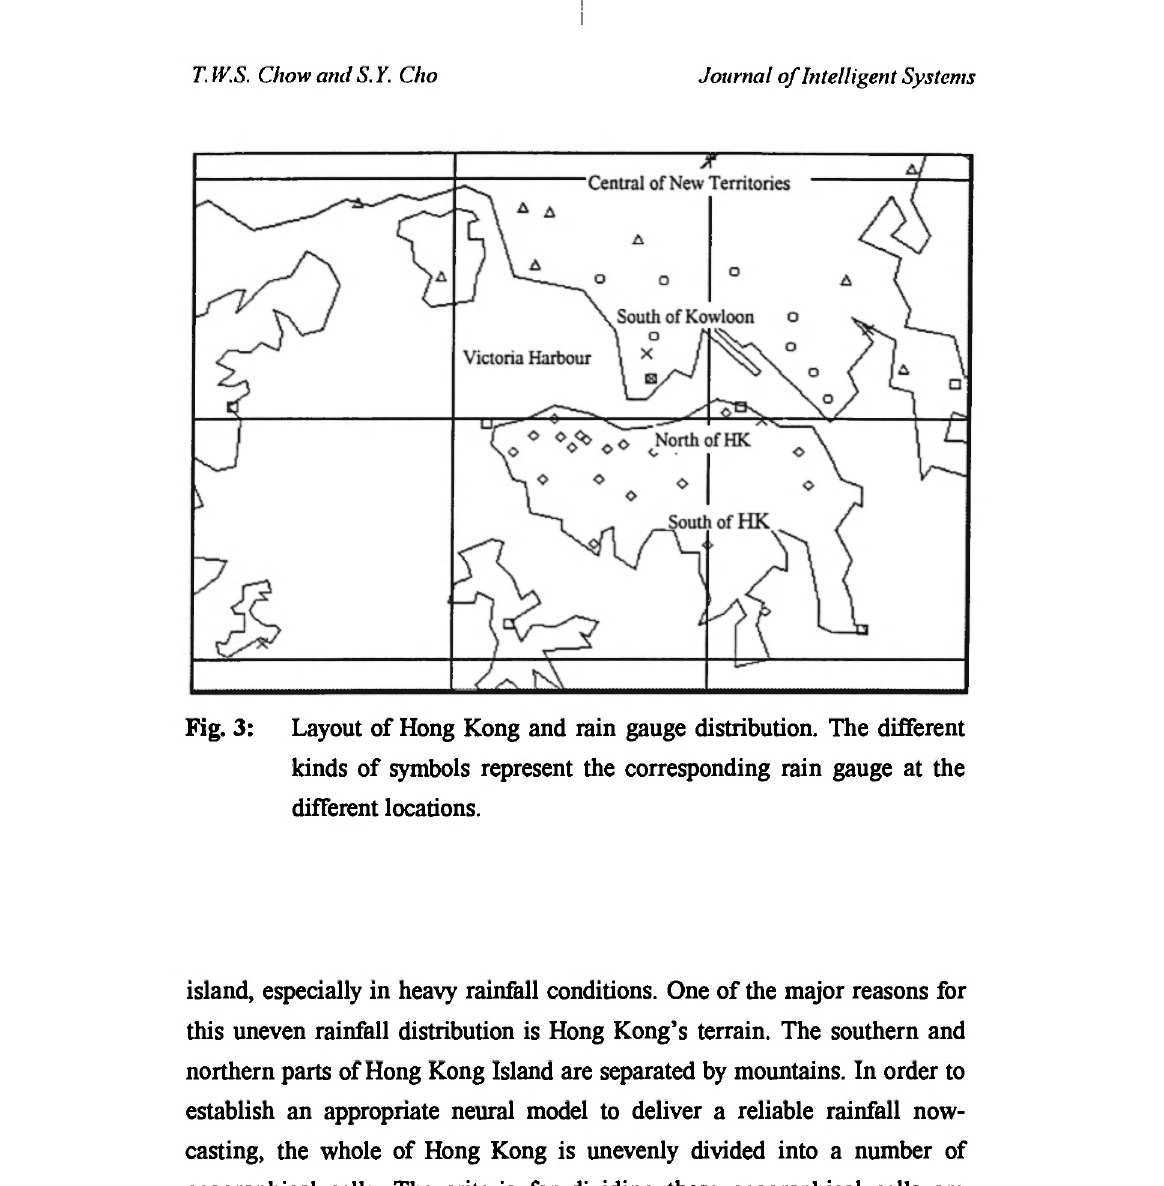
Fig. 3: Layout of Hong Kong and rain gauge distribution. The different kinds of symbols represent the corresponding rain gauge at the different